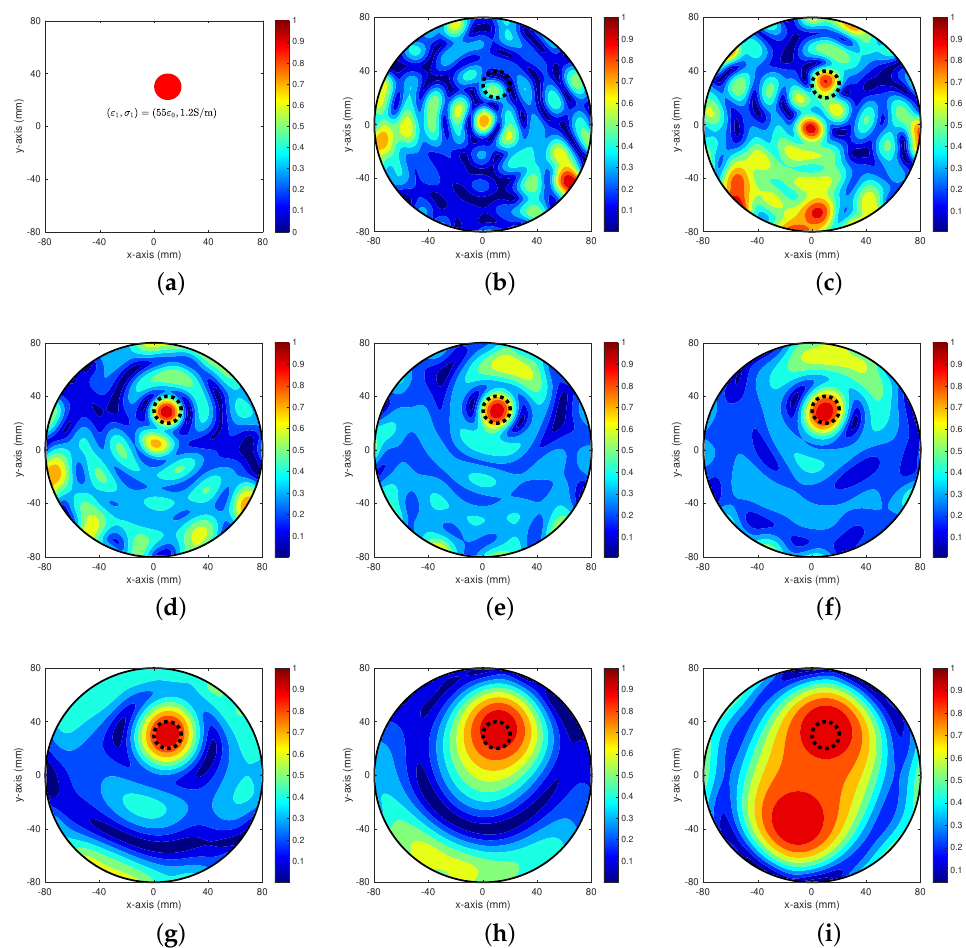
Figure 2. (Example 1) Maps of F BS ( r , n ) . Black-colored dashed line describes the boundary of ob- jective. ( a ) Small objective, ( b ) n = 1, ( c ) n = 2, ( d ) n = 3, ( e ) n = 4, ( f ) n = 5, ( g ) n = 6, ( h ) n = 7, ( i ) n =